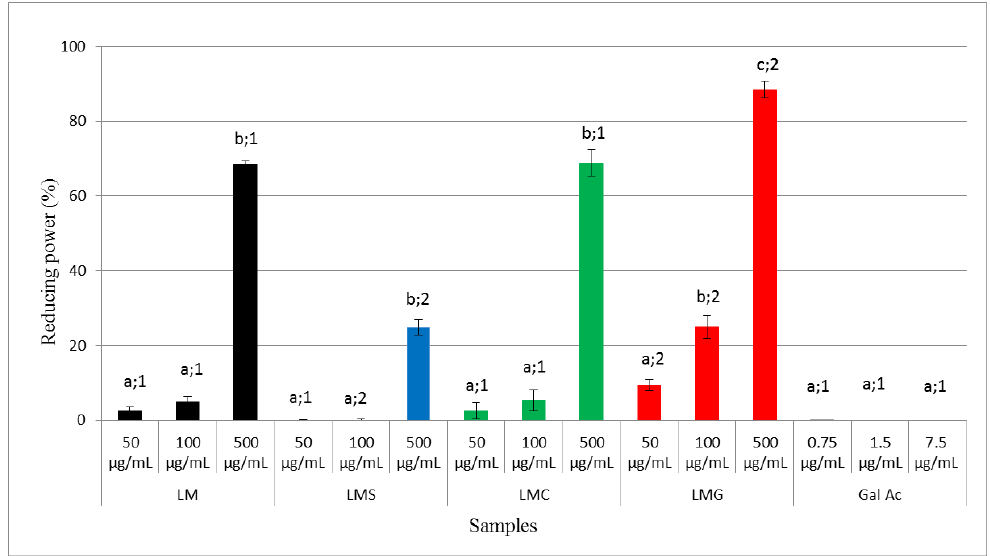
Figure 4. Reducing powers of LM ( black ), LMS ( blue ), LMC ( green ), and LMG ( red ). The gallic acid (Gal Ac) was used at the amounts corresponding to the used LMG concentrations. Different letters represent significant differences between LM and LMS/LMC/LMG at different concentrations. Different numbers represent a significant difference between LM and LMS or between LM and LMC or between LM and LMG at the same concentrations ( p < 0.05).